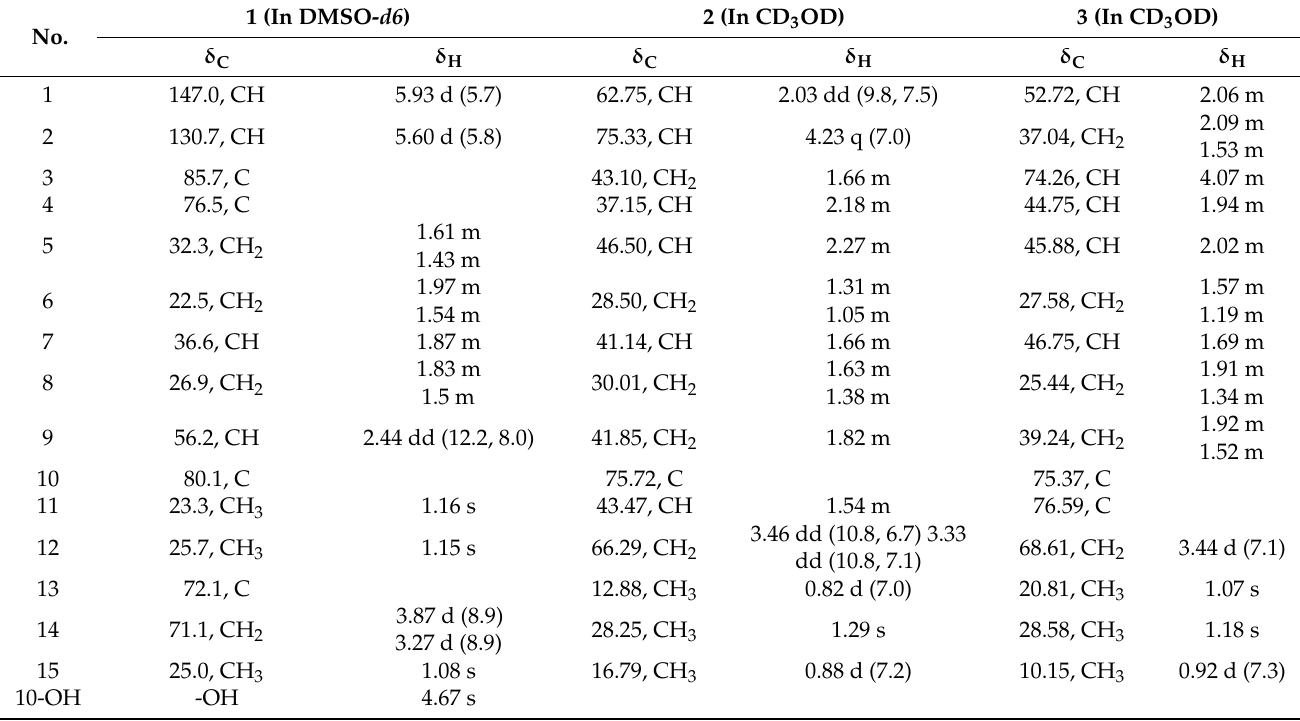
Table 1. 1 H (500 MHz) and 13 C (125 MHz) NMR data for compounds 1 − 3 ( δ in ppm, J in